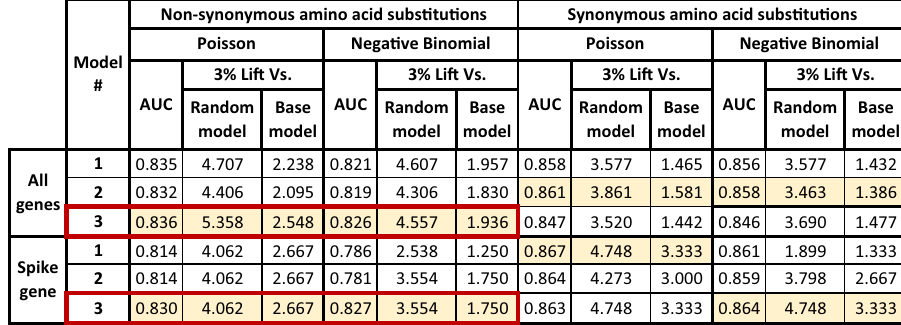
Fig. 3 Prediction results for the top three models. We use the top three Poisson and Negative Binomial models from Fig. 1 for prediction on the test dataset. Results for the entire genome are in the fi rst three rows, for the spike protein only in the last three. Results are shown separately for predicting non-synonymous amino acid substitutions (left half) and predicting synonymous substitutions (right half, these results are not discussed in the text). The fi rst column in each table quarter shows the area under the ROC curve (AUC) for the corresponding prediction task and modeling approach. We highlighted the top-scoring model for every (substitution type, locus, approach) combination. Overall, we obtained high AUC scores, showing that the models successfully predicted many of the substitutions. Each quarter ’ s second and third columns are 3% lift scores of each model versus the random and more elaborate base models (see text and Methods). The top models signi fi cantly outperform both baselines, stressing our approach ’ s bene fi ts over more naive statistical predictions. The model we analyzed further in the text (third Poisson model for non-synonymous amino acid substitutions) is also red- framed.